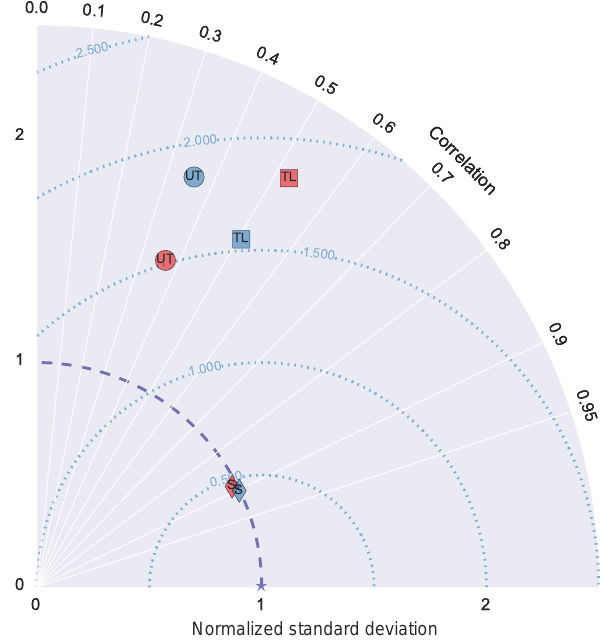
2 Normalized standard deviation Figure 5. Modified Taylor diagram summarizing the performance of MLS v3 (red) and v4 (blue) retrievals relative to sonde mea- surements in three atmospheric layers: the upper troposphere (UT; circles; 178–261hPa), tropopause layer (TL; squares; 68–147hPa) and the stratosphere (S; diamonds; 10–56hPa). Layer averages are pressure weighted, as in the text. Blue dotted lines mark isolines of root mean square error (RMSE) relative to the corresponding sonde measurements (purple